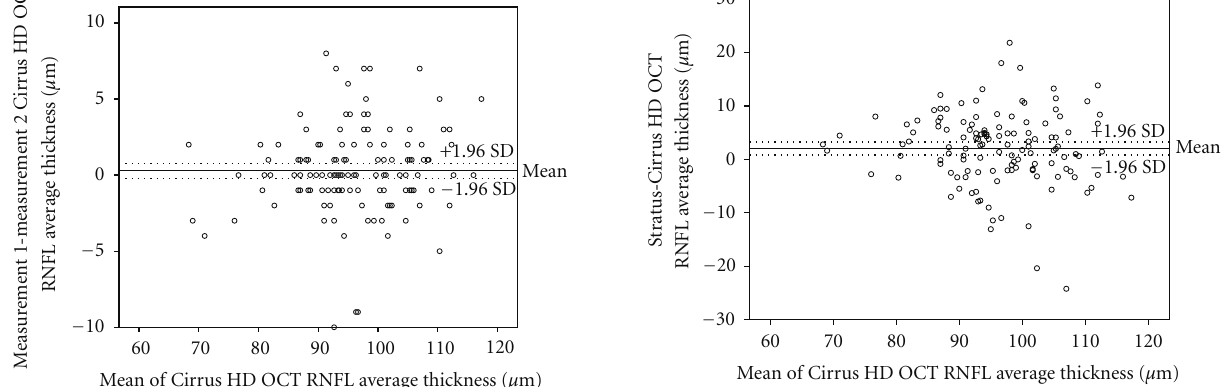
Figure 2: Bland-Altman plots of the agreement in retinal nerve fiber layer (RNFL) thickness between Cirrus HD OCT measure- ment 1 and Cirrus HD OCT measurement 2. The di ff erence (Cirrus HD OCT average RNFL thickness measurement 1 minus Cirrus HD OCT average RNFL thickness measurement 2) was plotted against the average of the three measurements for the average RNFL thickness Cirrus HD OCT measurements. SD: standard deviation.